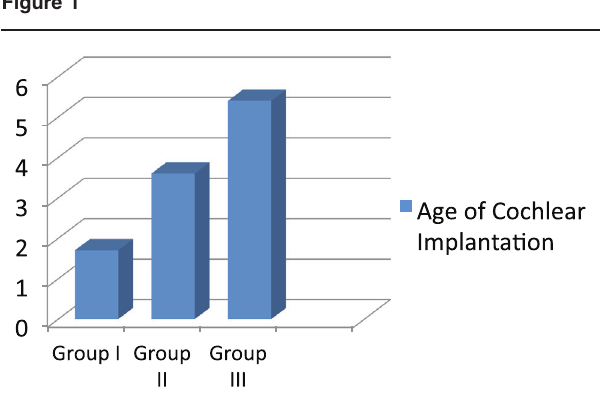
Comparison between the three groups regarding preimplantation LittlEARS